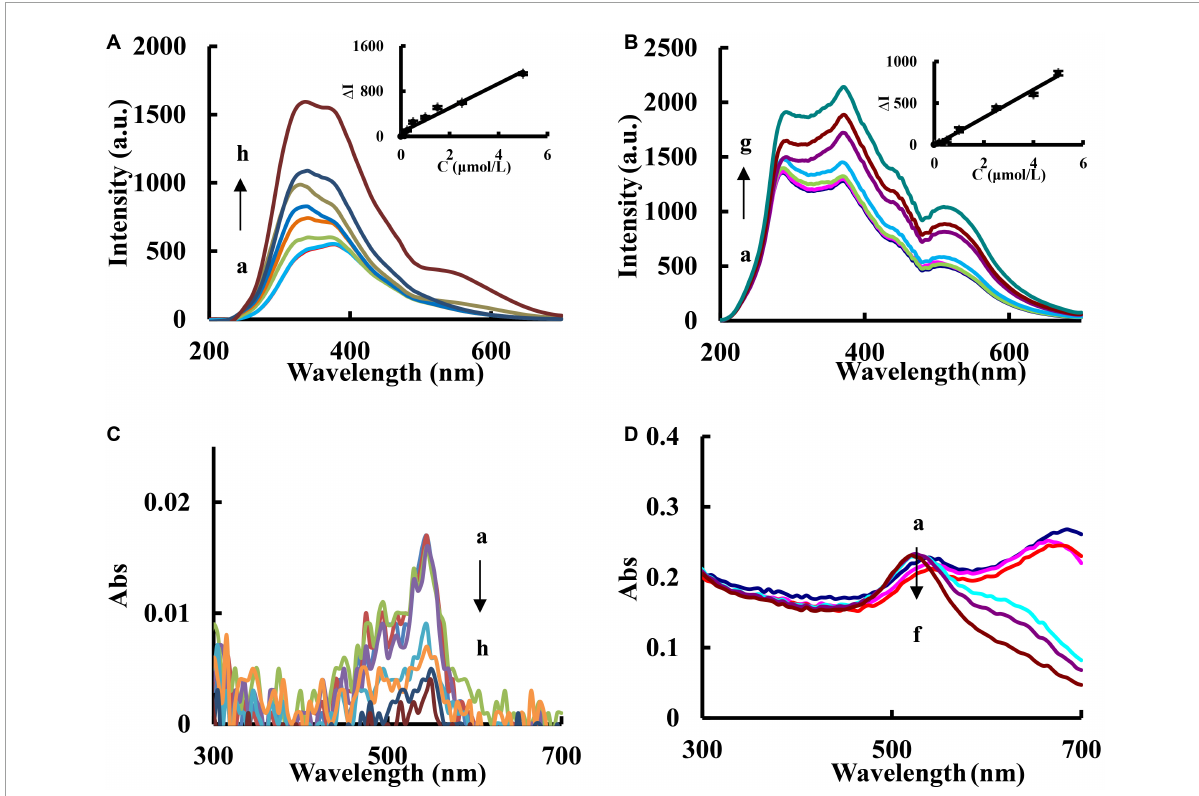
FIGURE5 RRS and UV-Vis absorption spectra of SO 32 − -BF-AuMOF/AuNP system. (A) RRS spectra of AuMOF system, (a) pH 6.80 PBS + 0.750 µ mol/L BF + 0.100 µ g/mL AuMOF; (b) a + 0.160 µ mol/L SO 32 − ; (c) a + 0.250 µ mol/L SO 32 − ; (d) a + 0.500 µ mol/L SO 32 − ; (e) a + 1.00 µ mol/L SO 32 − ; (f) a + 1.50 µ mol/L SO 32 − ; (g) a + 2.50 µ mol/L SO 32 − ; (h) a + 3.00 µ mol/L SO 32 − . (B) RRS spectra of AuNP system, (a) pH 6.80 PBS + 0.750 µ mol/L BF + 0.0725 mmol/L AuNP; (b) a + 0.100 µ mol/L SO 32 − ; (c) a + 0.500 µ mol/L SO 32 − ; (d) a + 1.00 µ mol/L SO 32 − ; (e) a + 2.50 µ mol/L SO 32 − ; (f) a + 4.00 µ mol/L SO 32 − ; (g) a + 5.00 µ mol/L SO 32 − . (C) UV-Vis absorption spectra of AuMOF system, (a) pH 6.80 PBS + 0.750 µ mol/L BF + 0.100 µ g/mL AuMOF; (b) a + 1.00 µ mol/L SO 32 − ; (c) a + 1.50 µ mol/L SO 32 − , (d) a + 2.50 µ mol/L SO 32 − ; (e) a + 15.0 µ mol/L SO 32 − ; (f) a + 25.0 µ mol/L SO 32 − ; (g) a + 35.0 µ mol/L SO 32 − ; (h) a + 40.0 µ mol/L SO 32 − . (D) UV-Vis absorption spectra of AuNP system, (a) pH 6.80 PBS + 0.750 µ mol/L BF + 0.0725 mmol/L AuNP; (b) a + 0.250 µ mol/L SO 32 − ; (c) a + 1.00 µ mol/L SO 32 − , (d) a + 4.00 µ mol/L SO 32 − ; (e)